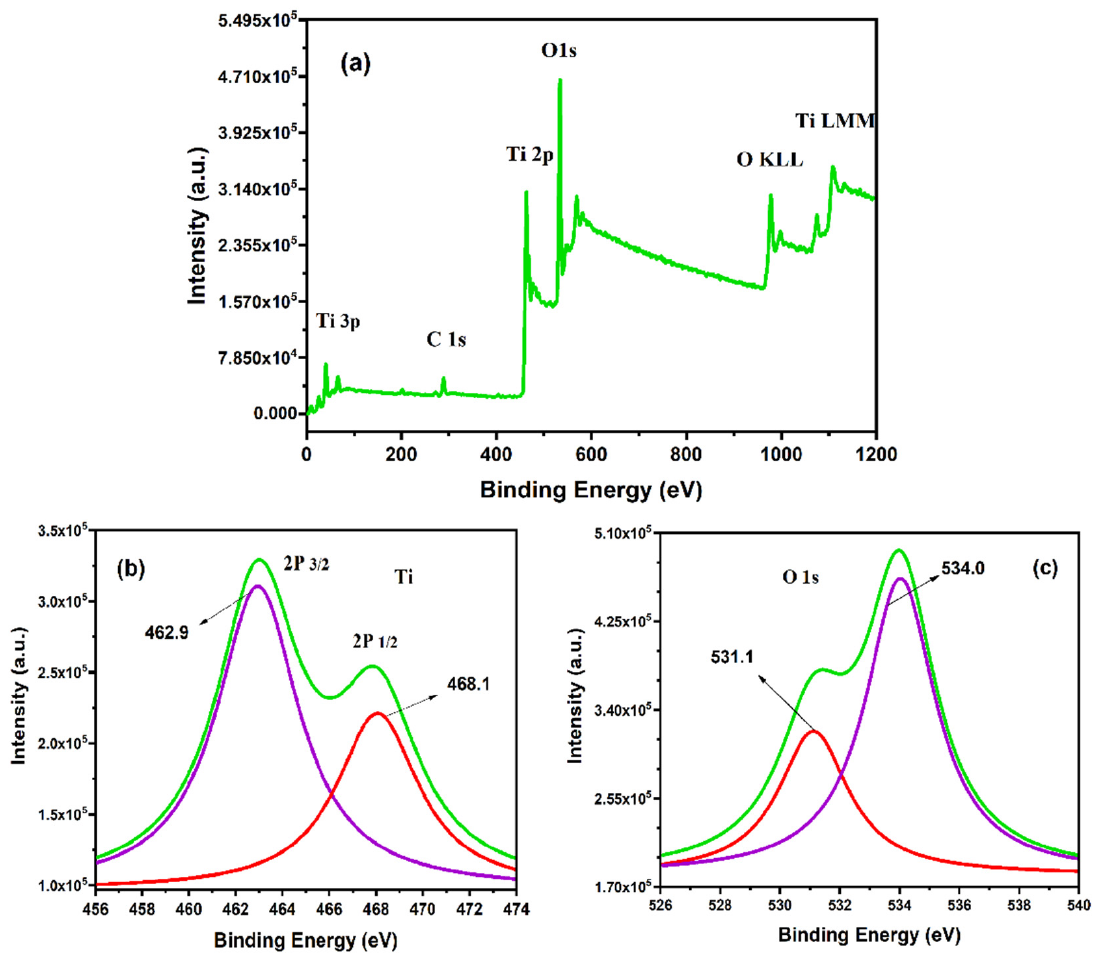
Figure 3. ( a ) XPS survey of the as-synthesized TiO 2 nanoparticles; ( b ) high-resolution Ti 2p; and ( c ) O 1s XPS spectra.